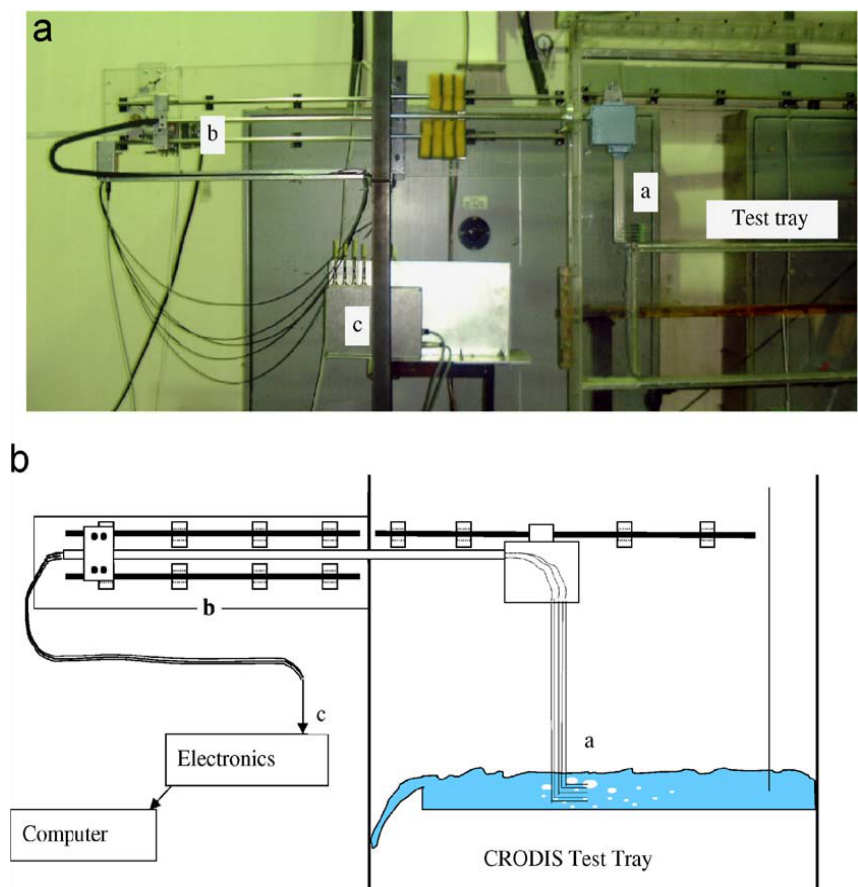
Figure 3. ( a ) Photograph of a flying optical probe system; ( b ) Diagram of a flying optical probe system